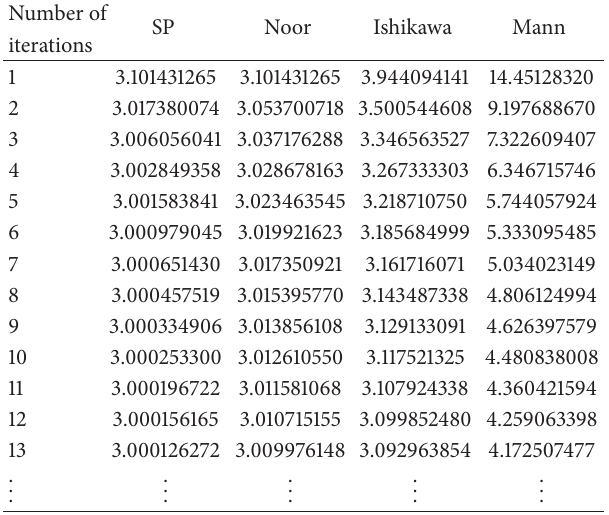
Table 3: Comparison speed of convergence among various iteration